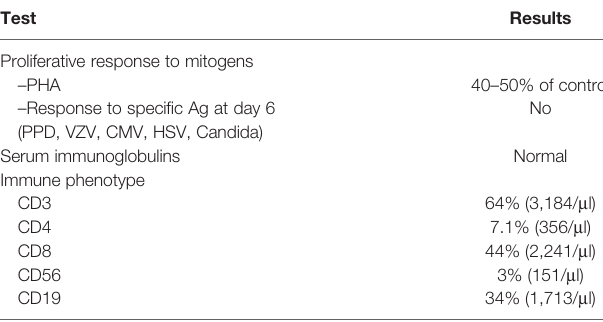
TABLE 1 | Immunological work-up of the MHCII-D patient who underwent thymic biopsy.